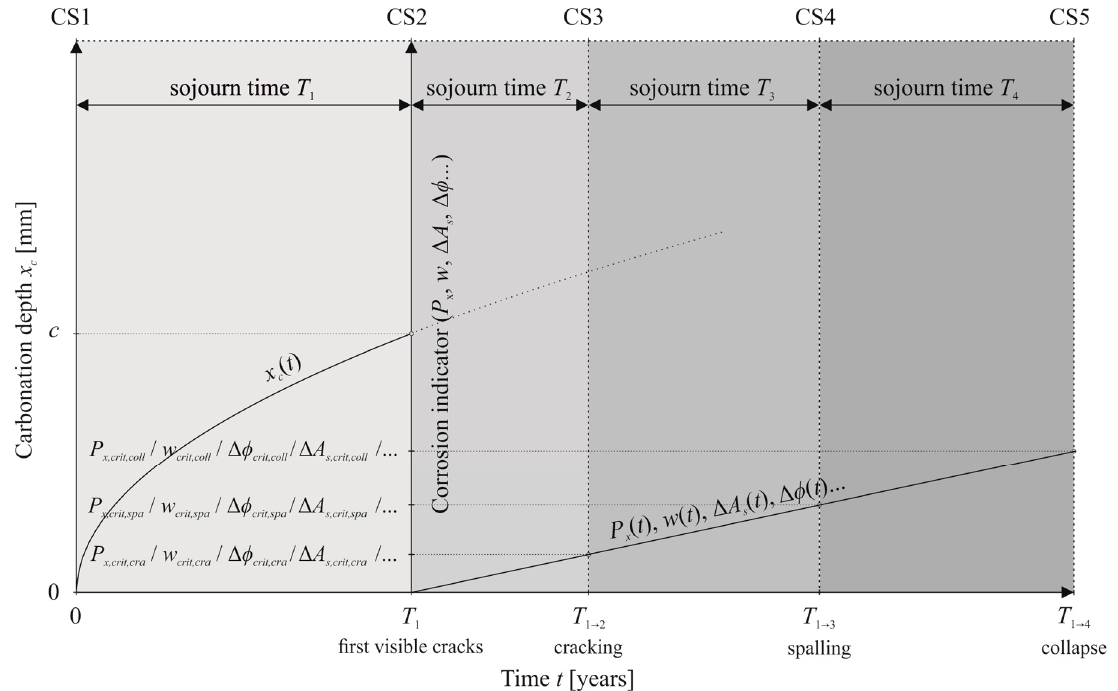
Figure 1. Relationship between periods of the carbonation-induced corrosion and sojourn times of the semi-Markov process.